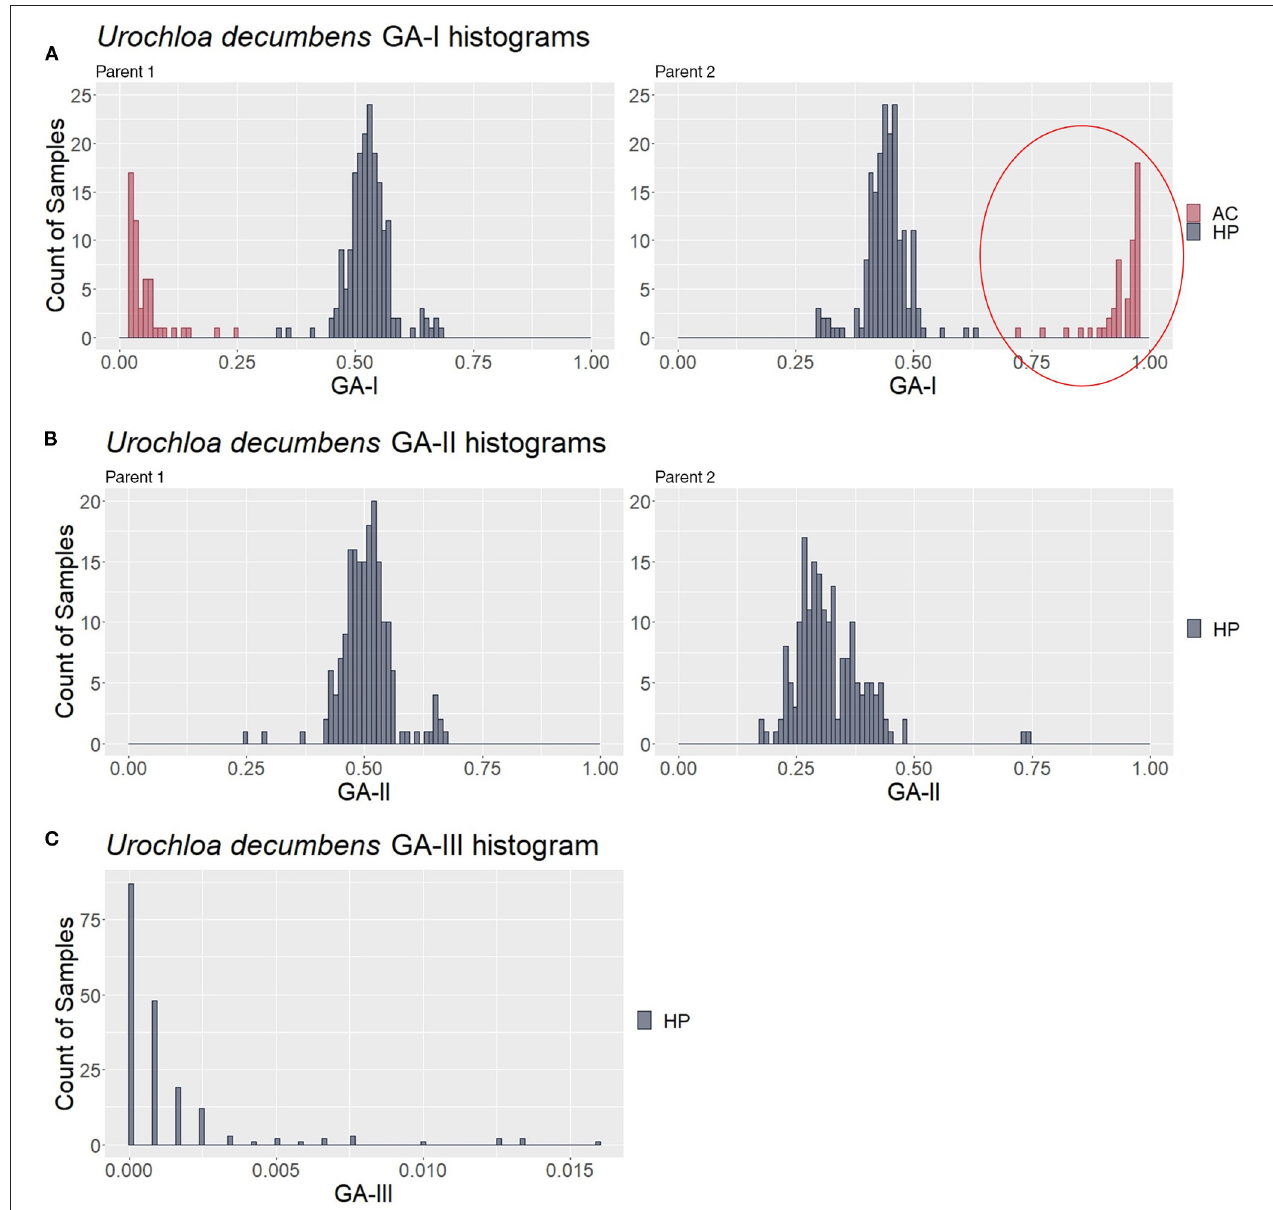
FIGURE 7 | Genotype analysis (GA)-based histograms of Urochloa decumbens with samples classified in the clustering analysis (CA). (A–C) show the results from GA-I, GA-II, and GA-III, respectively. The red circle highlights the identified apomictic clone (AC) contaminants in contrast to the hybrid progeny